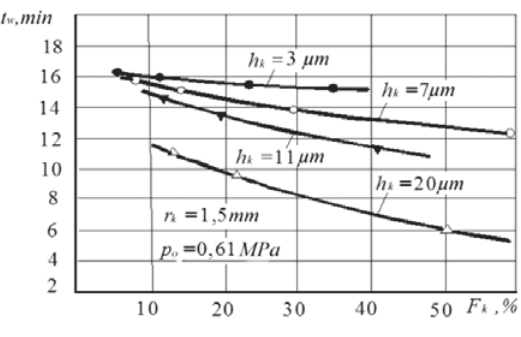
Fig. 13. Dependence of the time of the micro running-in completion t w on the relative area of micro grooves F